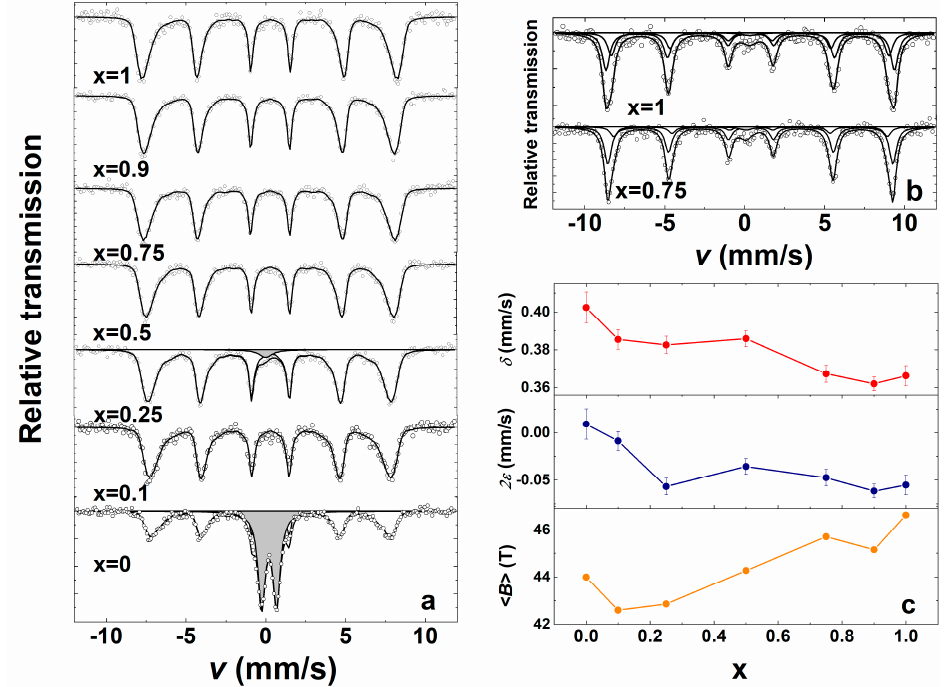
Figure 7. Mössbauer spectra of Bi 1-x La x Fe 0.85 Mn 0.15 O 3 samples at 296 K ( a ) and 10 K ( b ) and dependence of parameters: isomer shift δ and quadrupole shift 2 ε , and average hyperfine field <B> of magnetically split part at 296 K on x ( c ).